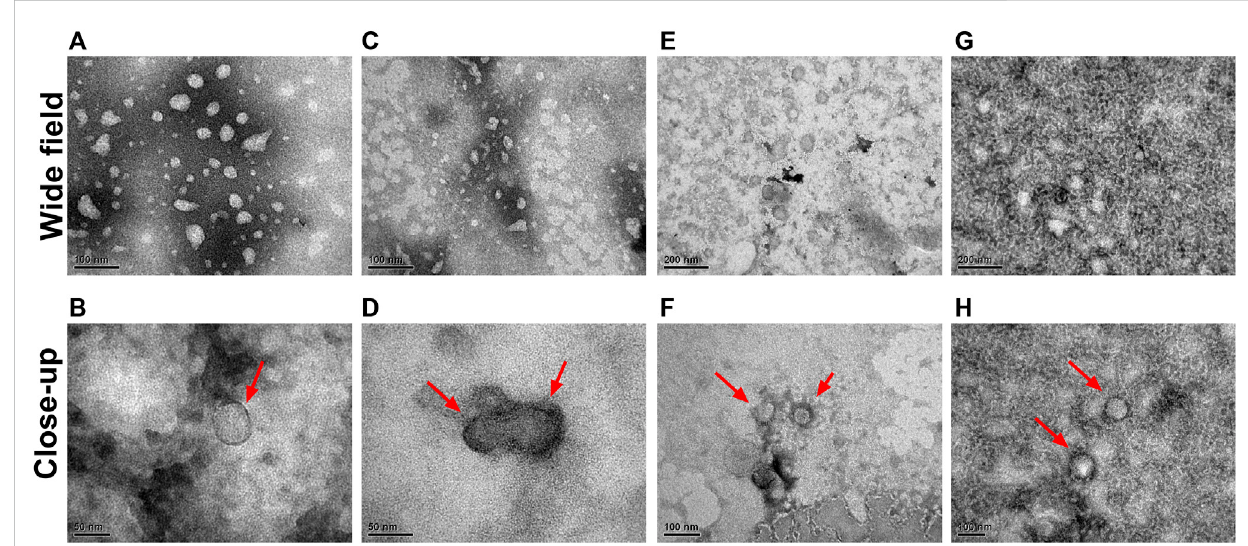
FIGURE 7 Representative TEM images of multiple extracellular vesicles. Representative images for small EVs from CM (A, B) , plasma (C, D) , urine (E, F) , and saliva (G,H) inthewideandclose-up fi eld.Scalebars (E,G) ,200 nm; (A,C,F,H) ,100 nm; (B,D) ,50 nm.TheshapeandsizeofsmallEVsextractedfromthe different samples were identi fi ed through TEM. Small EVs are marked by red